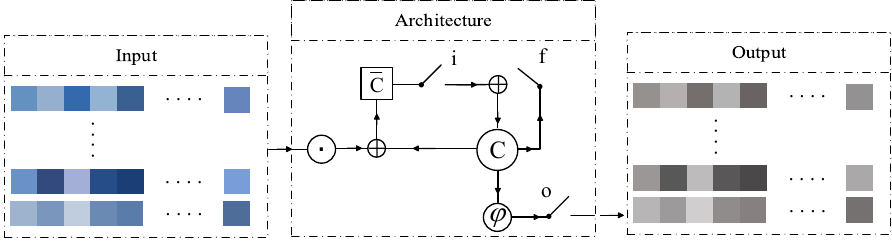
Figure 2. The input, architecture, and output of the long short-term memory